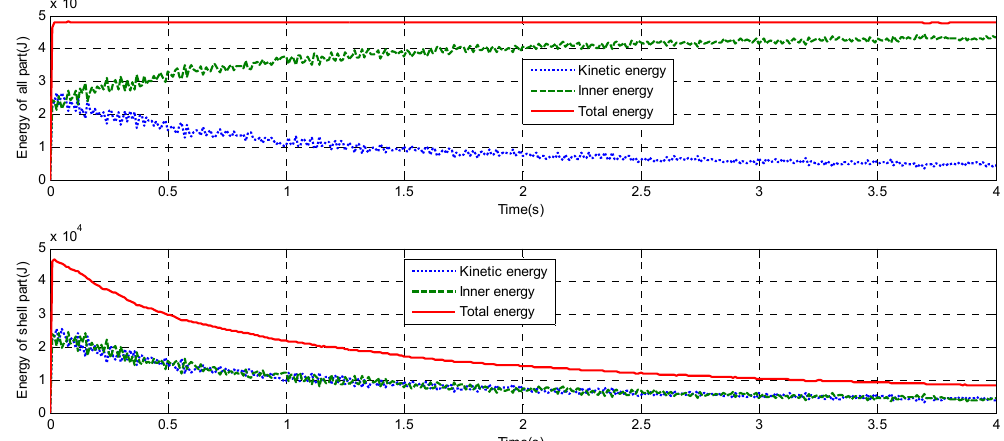
Figure 16. The plot of global and shell part energy vs. time. ( a ) The energy plot of all parts in the simulation, ( b ) The energy plot of shell part